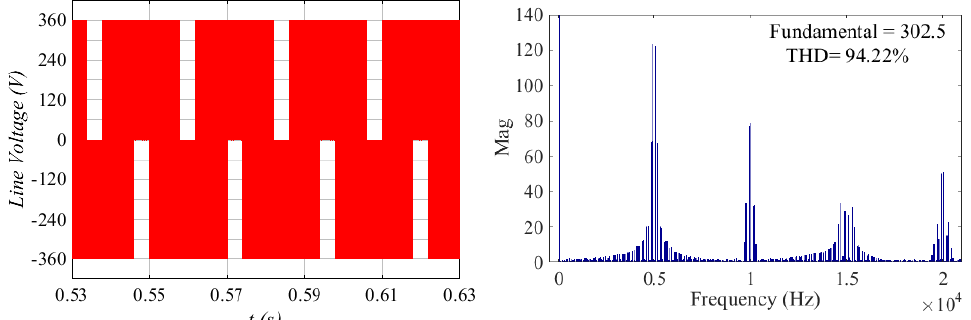
Figure 14. Simulation waveforms of line voltage u ab for DZICMV at m = 0.9703: ( left ) line voltage u ab ( right ) the FFT analysis of u ab .